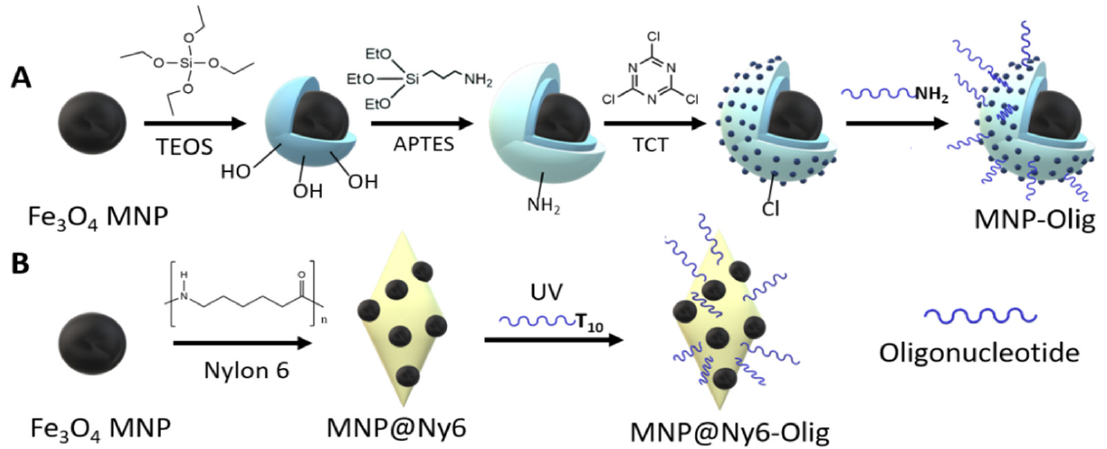
Figure 1. TEM images of magnetic nanoparticles (MNPs). ( A ) High-magnification TEM image initial Fe 3 O4 MNPs, the bar indicates 100 nm. ( B ) Low-magnification TEM image MNP1%@Ny6, the bar indicates 2 μm. ( C ) High-magnification TEM image MNP1%@Ny6, the bar indicates 400 nm. ( D ) Low- magnification TEM image MNP5%@Ny6, the bar indicates 1 μm. ( E ) High-magnification TEM image MNP5%@Ny6, the bar indicates 200 nm.